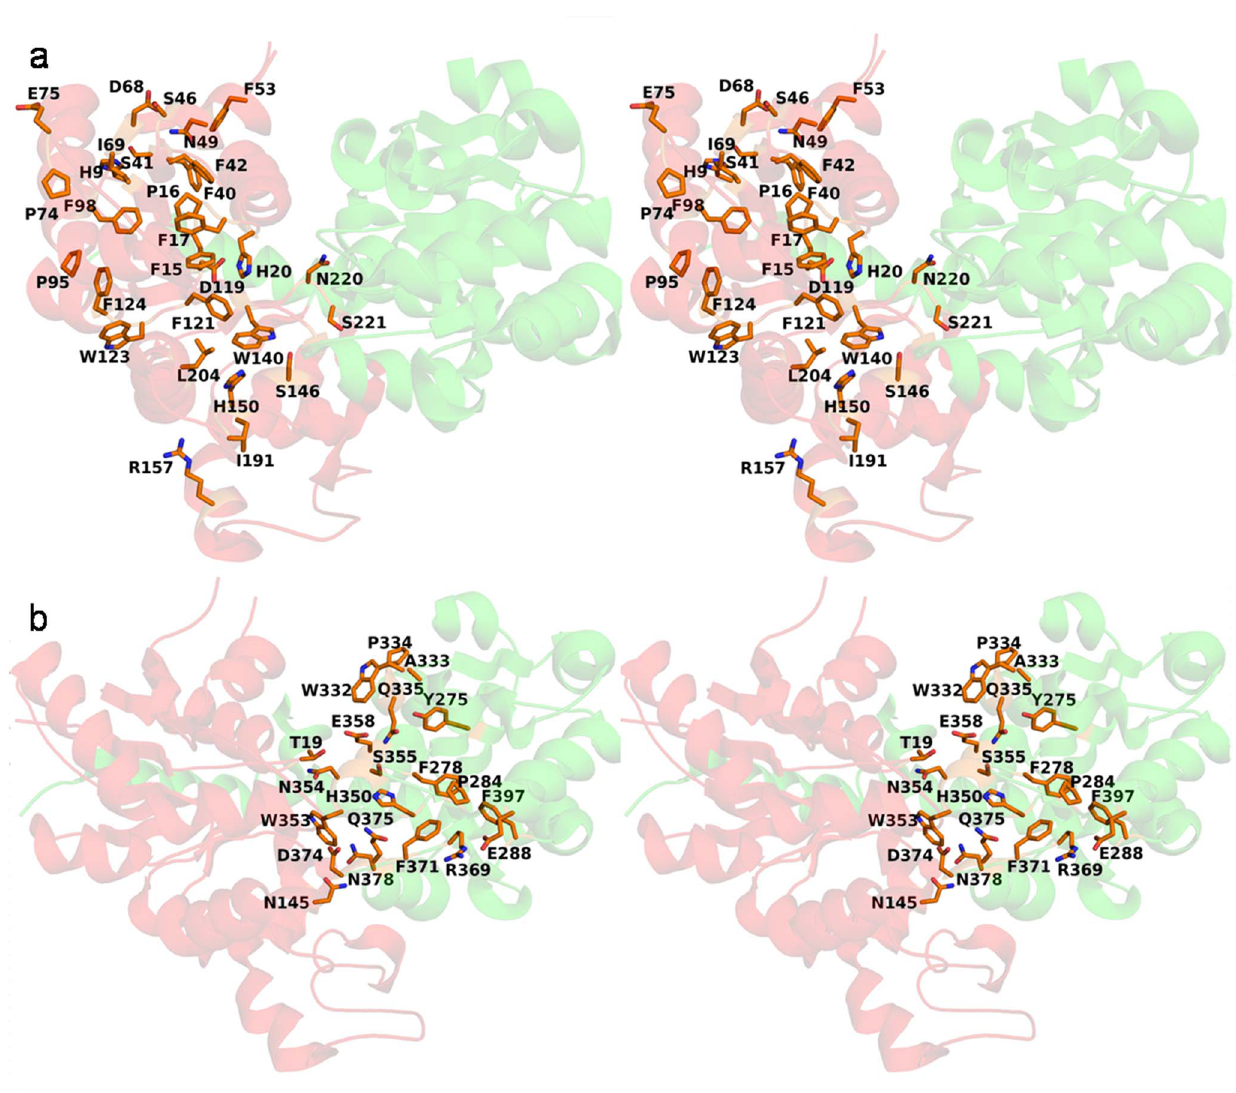
Figure 4. Conserved amino acids of N-terminal and C-terminal domain of UGT. a Stereo image representing cartoon drawing of UGT from V. vinifera with conserved amino acids of the NTD shown in stick form. b Stereo image representing cartoon drawing of UGT from V. vinifera with conserved amino acids of the CTD shown in stick form.